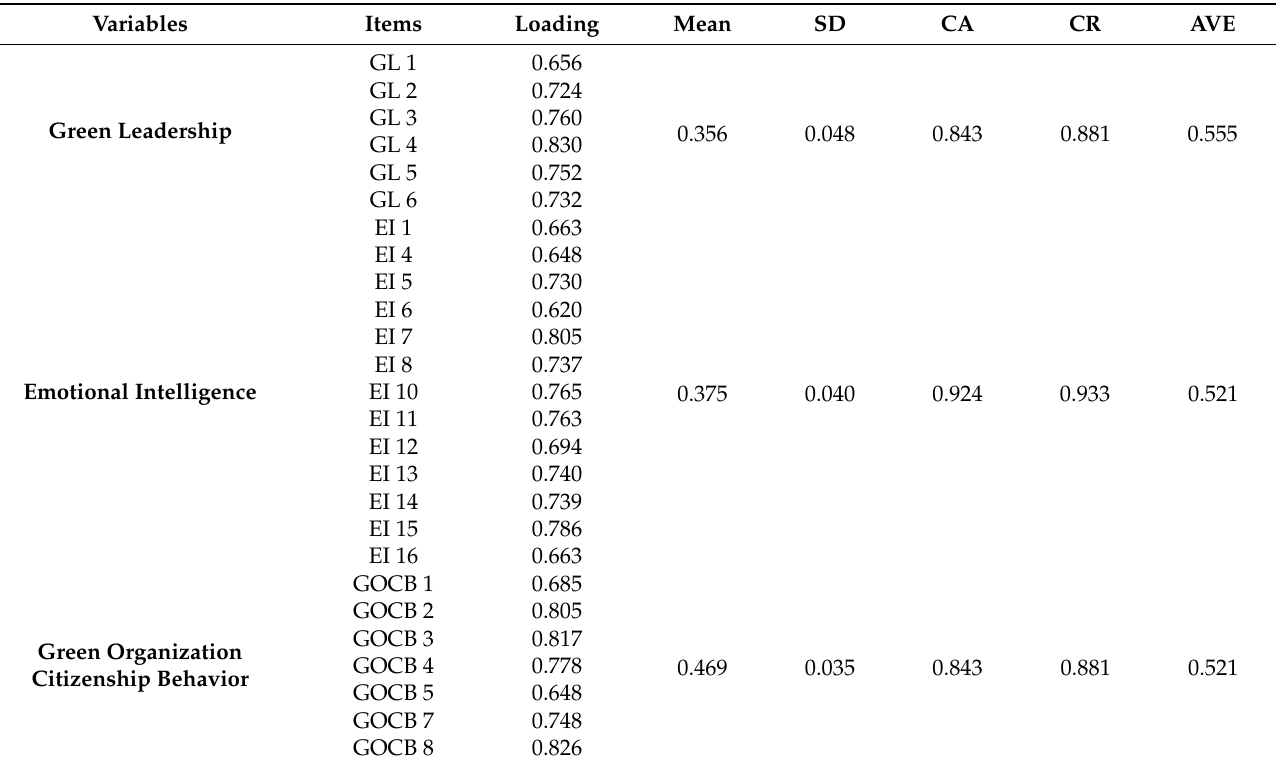
Table 2. Factor Loading, Mean, SD, CA, CR, AVE.